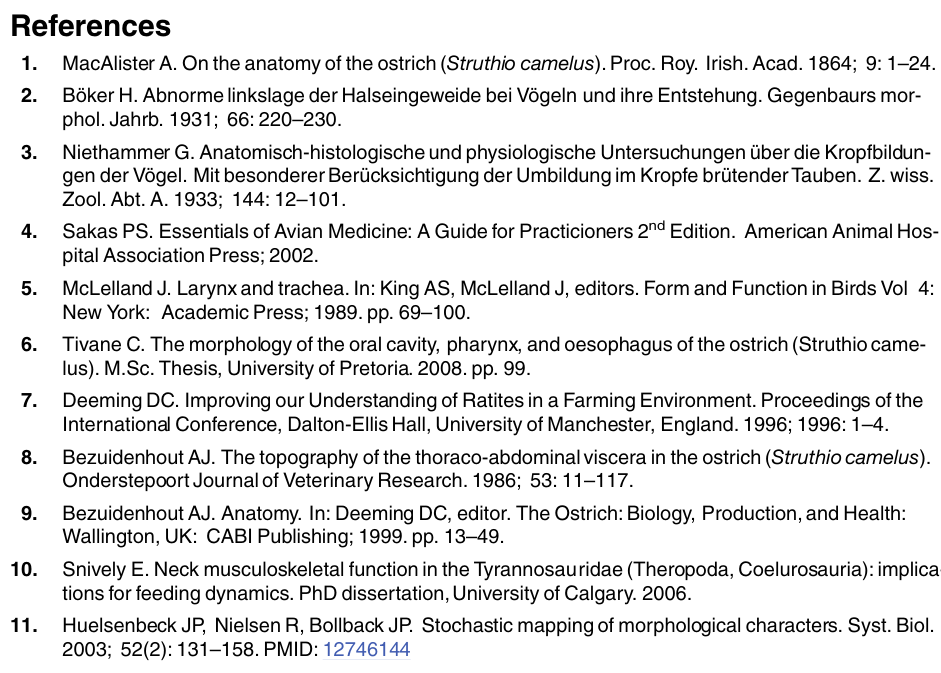
S7 Fig. Passeriformes. (A) Hirundo rustica . (B) Wilsonia canadensis . (C) Cardinalis cardinalis . (D) Bombycilla cedrorum . (E) Seiurus aurocapilla . (F) Seiurus aurocapilla ventral view. (G) Turdus migratorius . (H) T . migratorius oblique view showing the entrance of the trachea and esophagus into the thorax. Tra = trachea; Eso = esophagus.